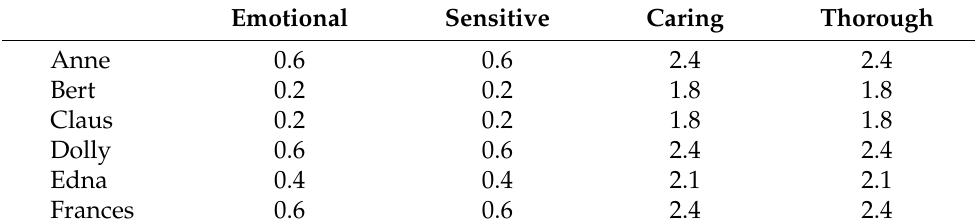
Table 2. Matrix of situation 2: “giving a speech” for behavioral level data.